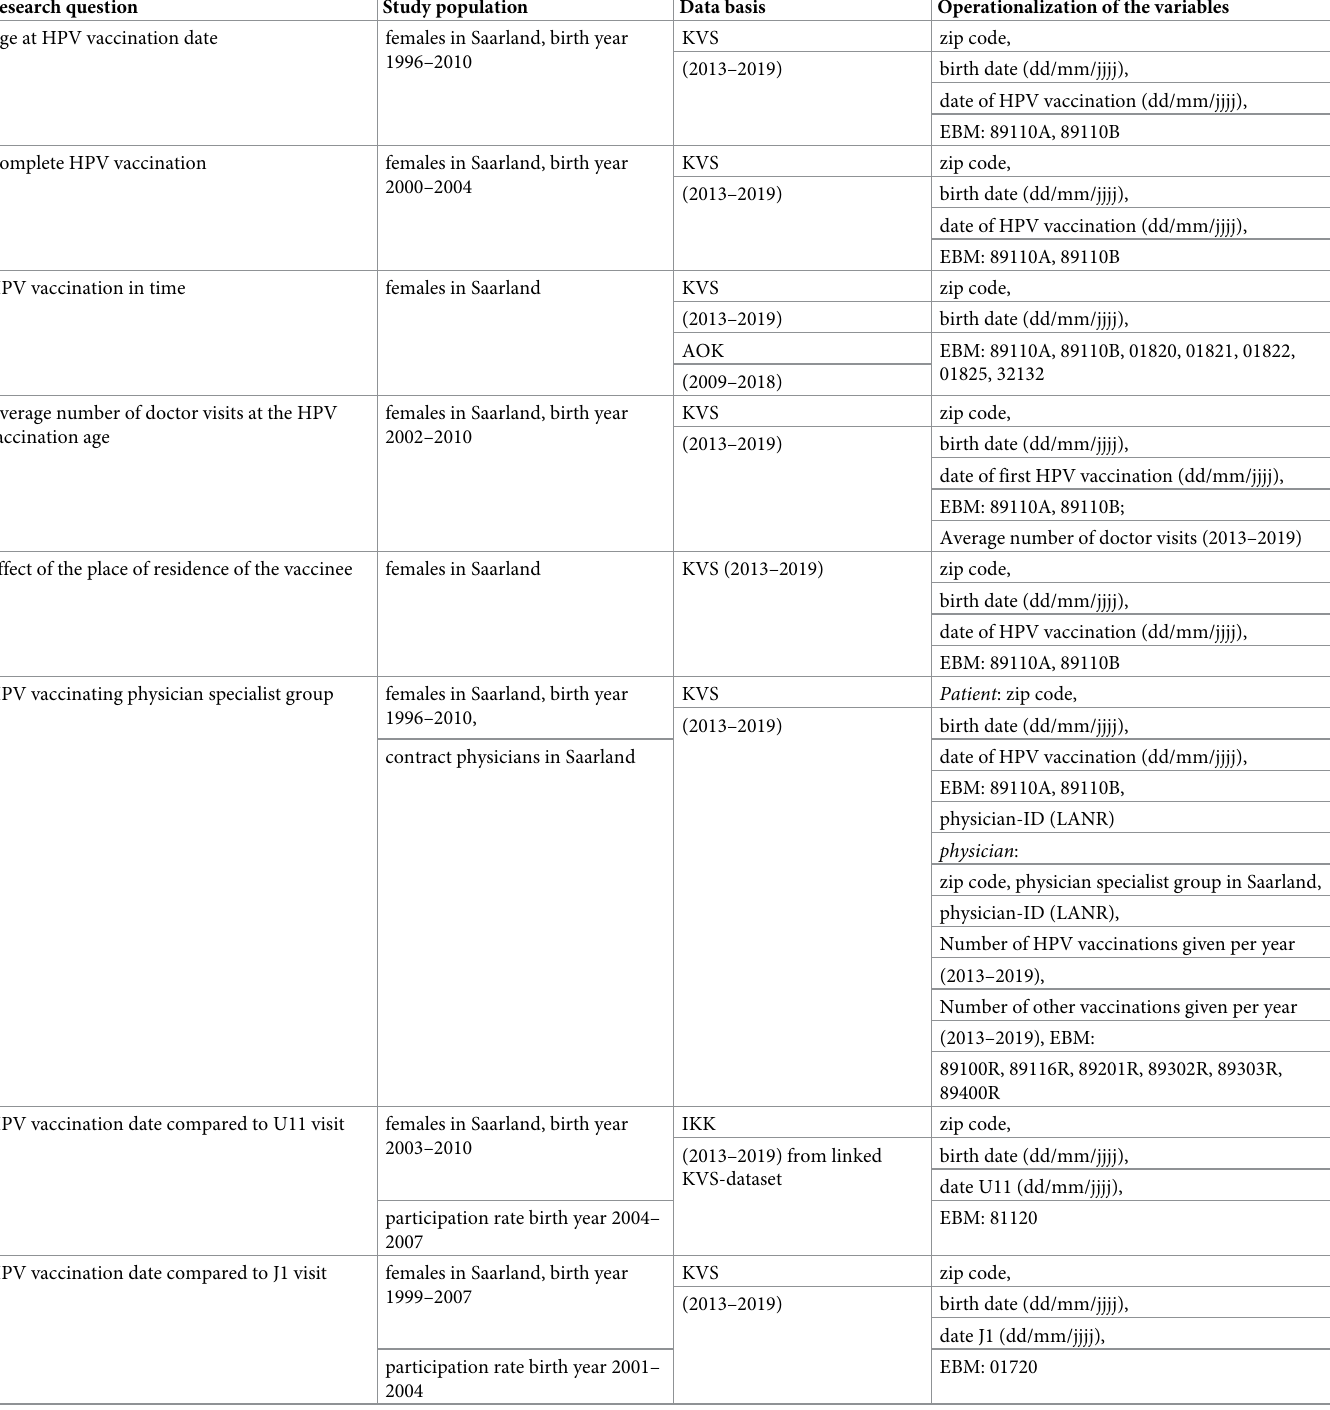
Table 1. Overview of the data sets used and the operationalization of the variables for the individual research